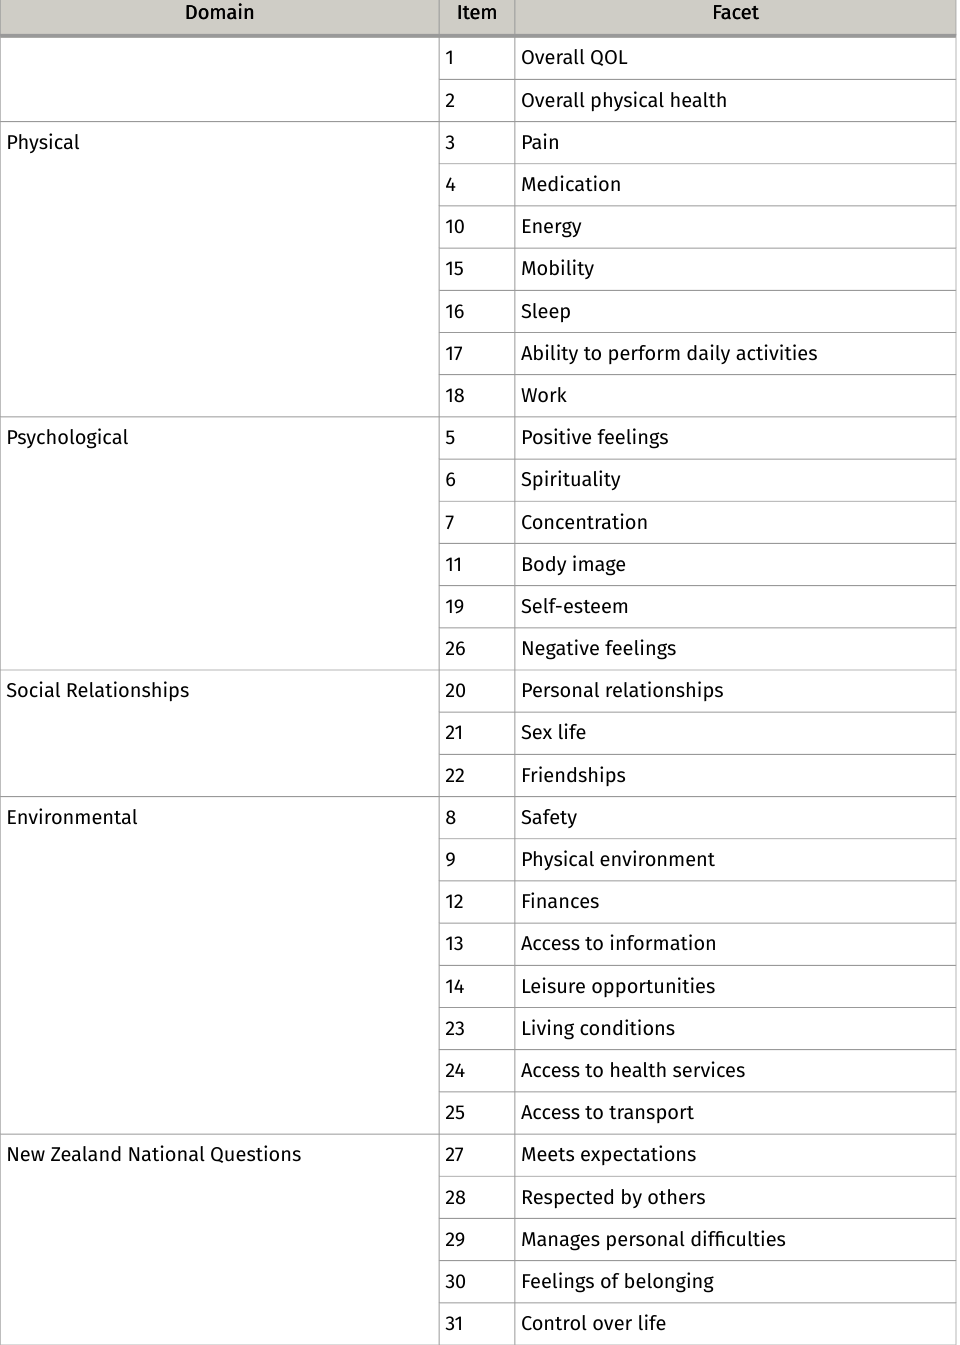
WHOQOL-BREF scoring manual (World Health Organization, 1998) is used to calcu- late domain scores (out of 20) and transformed domain scores (out of 100) for ques- tions 3 to 26. Q1, Q2, and the New Zealand national questions do not contribute to the domain scores and are considered on their own. Prior to completing the NZ WHOQOL- BREF, participants are asked to reflect on their lives over the past two weeks. Ques- tions are scored on a five-point Likert scale with “1” indicating lower HRQOL, and “5” indicating higher HRQOL. The NZ WHOQOL-BREF also includes an “About Me” sec- tion (seven-items) with demographic questions. The NZ WHOQOL-BREF was present- ed in English. The NZ WHOQOL-BREF questions and their corresponding domains and facets are presented in Table